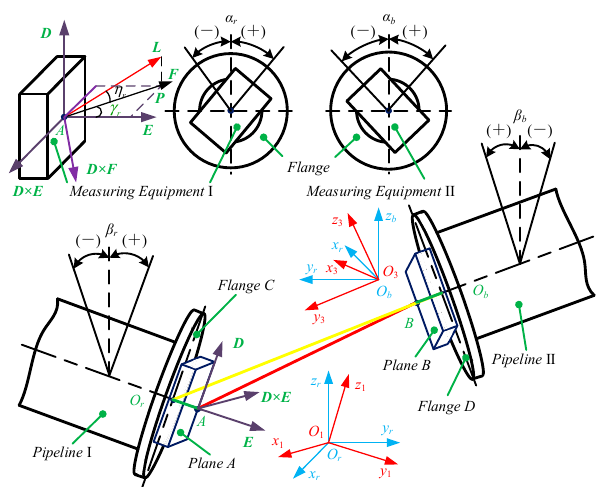
Figure 5. Mathematical model II of the measuring device based on flange center positioning.